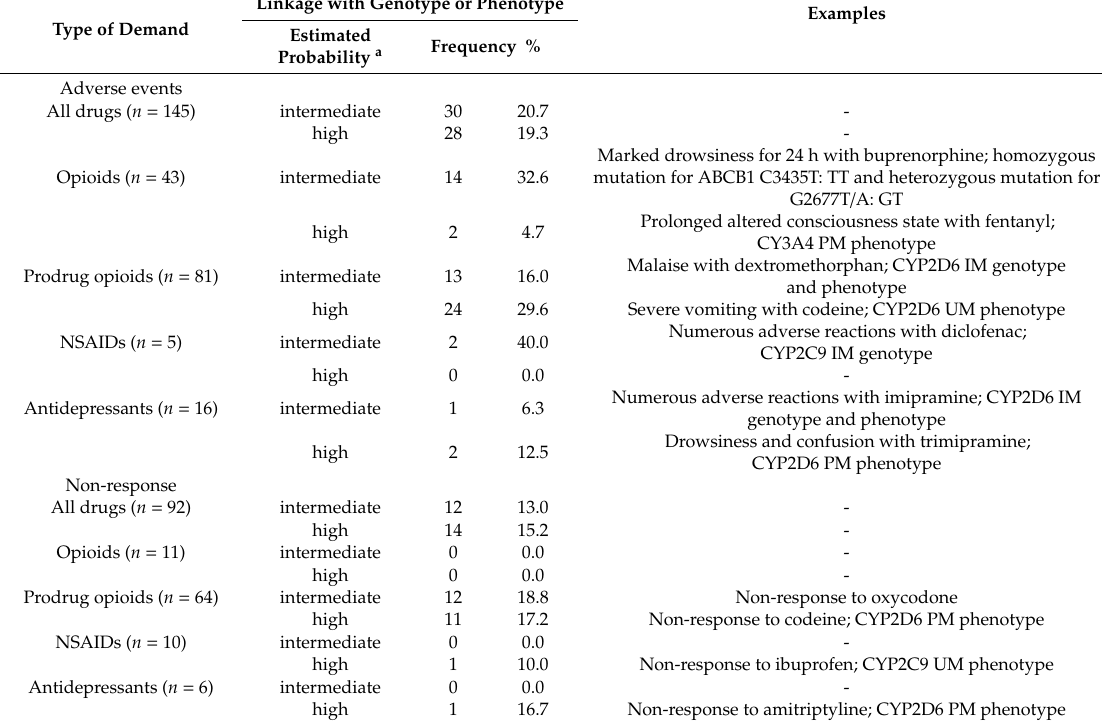
Table 5. Linkage between the type of demand and patient genotype or phenotype by analgesic